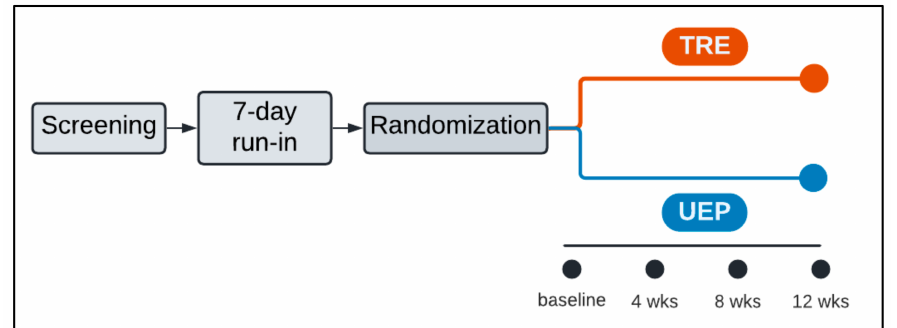
Figure 1. Study design. After screening for eligibility, participants completed a one-week run-in during which they experienced both meal-timing patterns. After successful completion of the run-in, participants were randomized to either the 12-week TRE (time-restricted eating) or UEP (usual eating pattern), during which they consumed only study food according to their assigned meal-timing pattern. During the 12-week intervention, participants consumed three meals per week